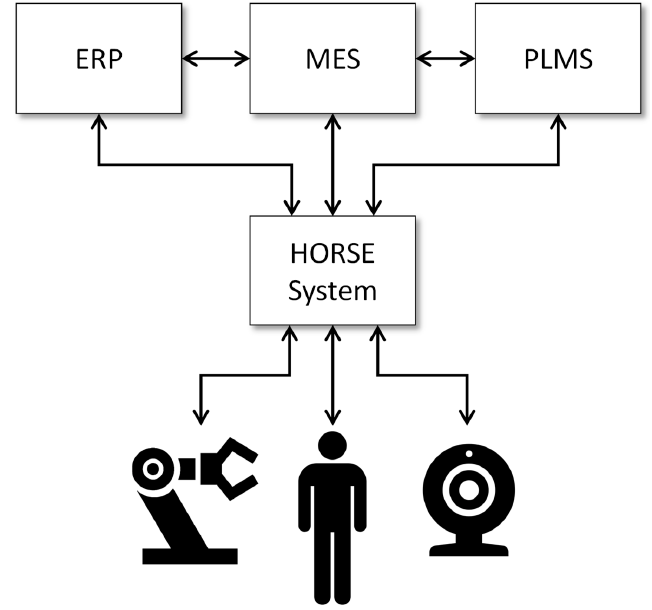
Figure 5. Context of the HORSE System simplified to only show typical systems.